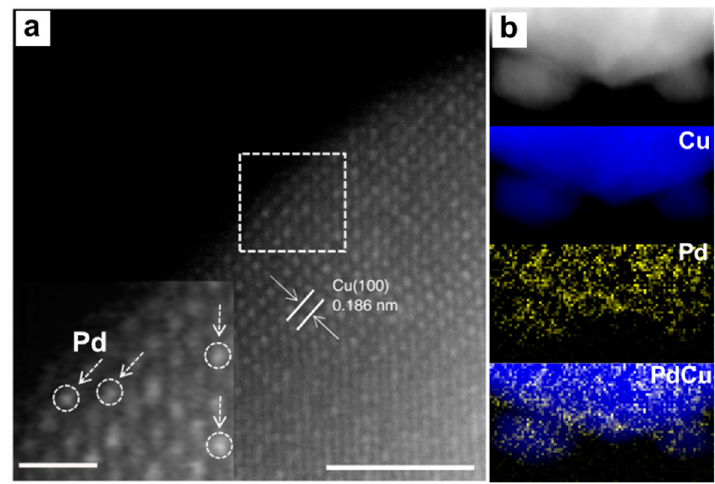
Figure 2. Structural characterization of point defects in Pd − doped Cu catalysts. ( a ) HAADF − STEM image and inverse FFT pattern (inset) of selected area. Scale bars are 2 nm. ( b ) EELS mapping. Reproduced with permission [36]. Copyright 2016, Springer Nature.